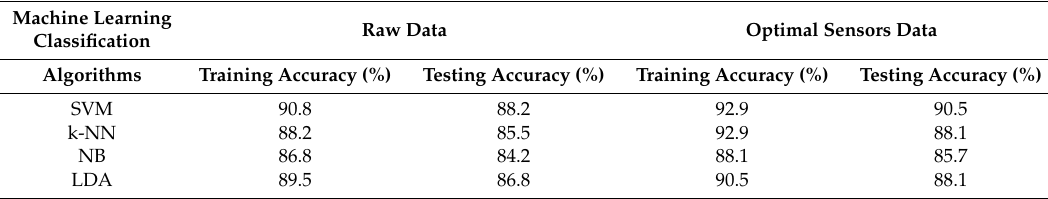
Table 6. Performance evaluation and accuracy comparison.